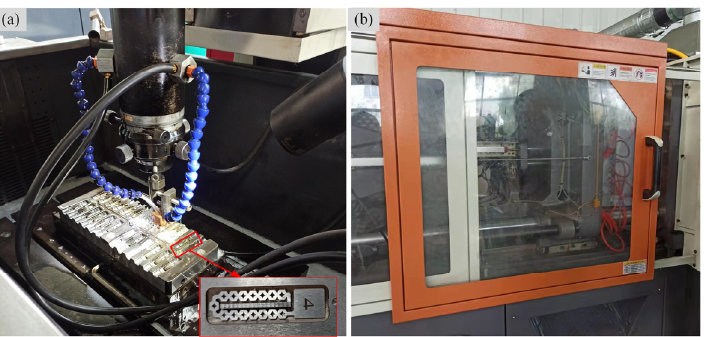
Figure 5. The manufacturing processes of the SWRLC emitter: ( a ) mold manufacturing by EDM; ( b ) injection molding production.